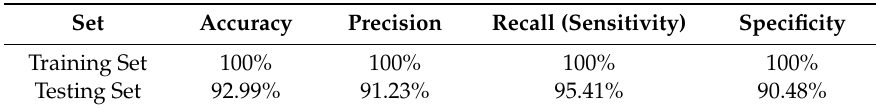
Table 3. Performance metrics of the optimized model for binary classification between immature and mature leukocytes on training and testing sets.